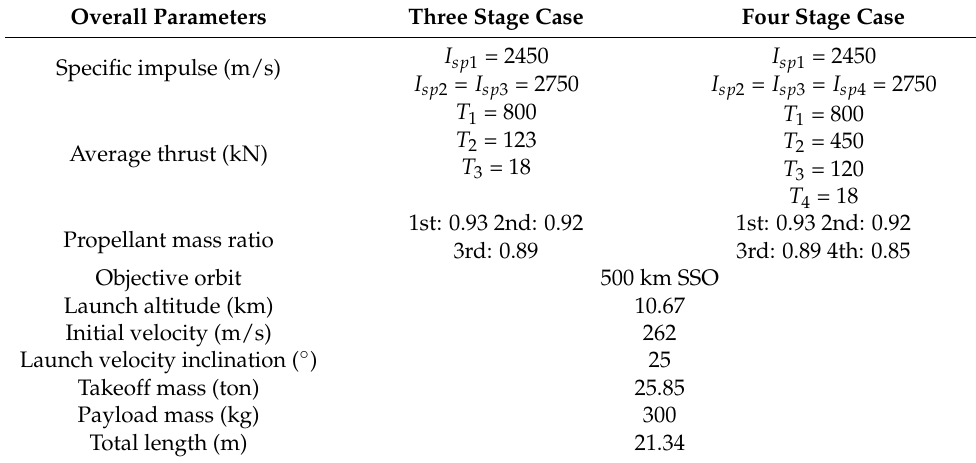
Table 1. Overall parameters of the air-launched vehicle. Overall Parameters Three Stage Case Four Stage